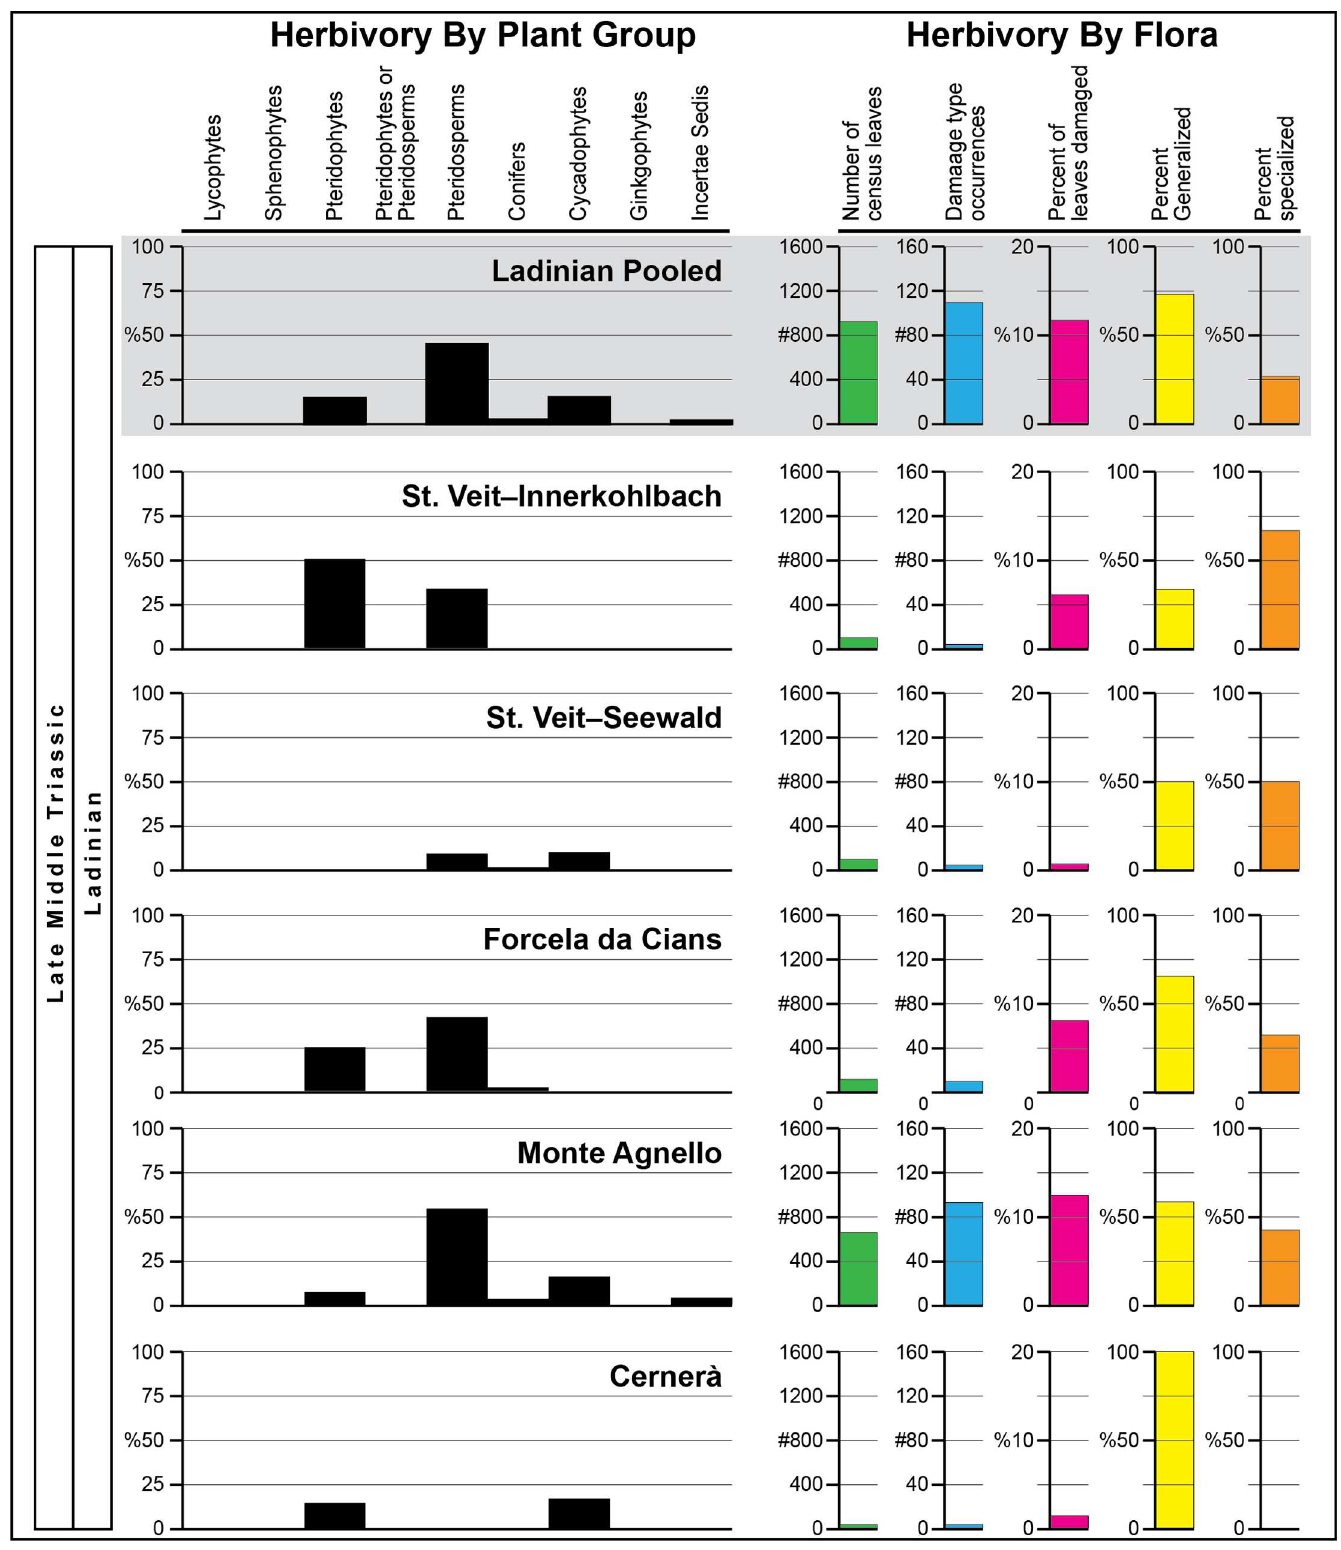
Fig 3. Quantitative distribution of plant–insect interactions Ladinian strata in northeastern Italy.